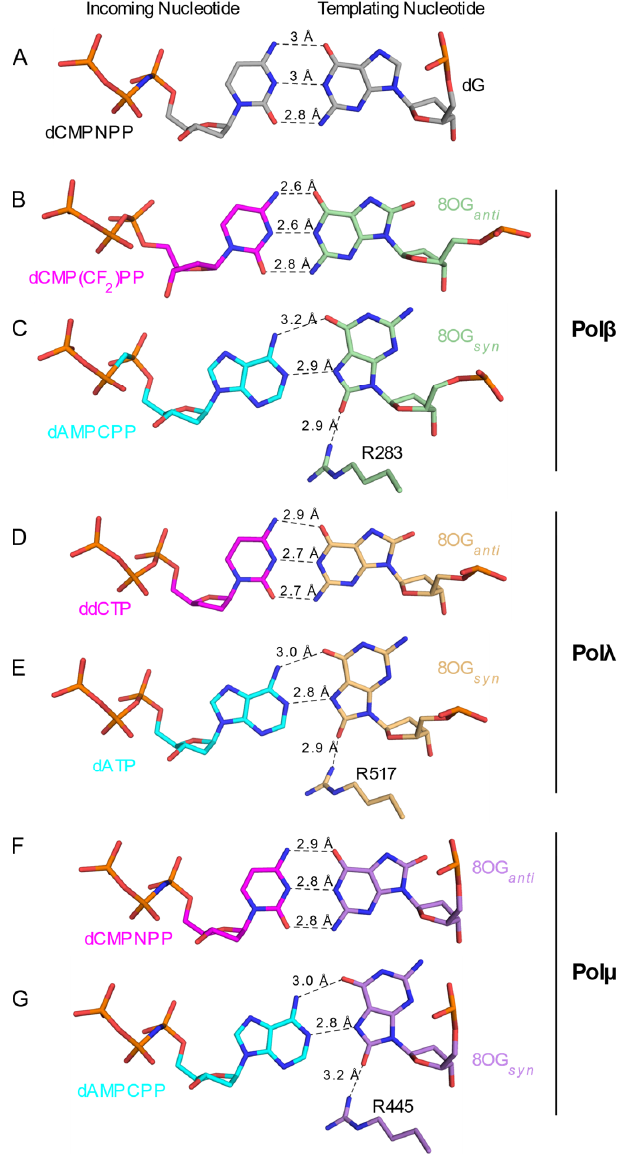
Figure 4. Comparison of base pairing interactions in Family X polymerases containing undamaged or oxidized template guanine nucleotides. Stick representations of the nascent base pair of either a correctly paired, undamaged guanine ( A ) bound in the active site of Polµ (PDB ID code 6P1V [35]), or oxidized template 8OG bound to Polβ (( B , C ), PDB ID codes 3RJI or 3RJF [54] for correct pairs in magenta and mispairs in cyan, respectively), Polλ (( D , E ), PDB ID codes 5IIJ or 5III [34] for correct pairs in magenta and mispairs in cyan, respectively), or Polµ (( F , G ), PDB ID codes 6P1P or 6P1N [35] for correct pairs in magenta in mispairs in cyan, respectively). The incoming nucleotides are shown on the left and the templating guanine nucleotides on the right. Probable hydrogen bonds are drawn as black dashed lines, with distances labeled.